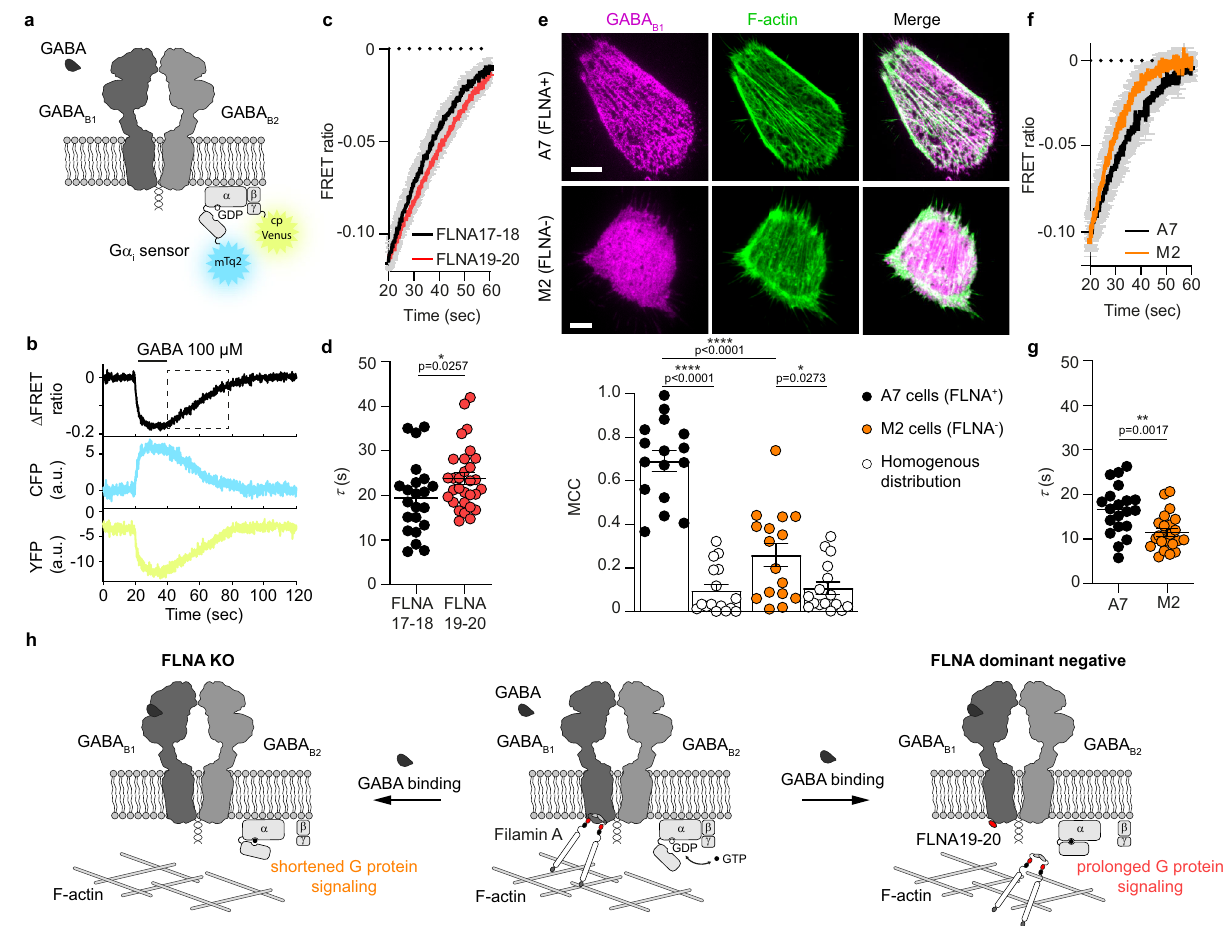
Fig.6|ImpactofGABA B -FLNAinteractionsonG i proteinsignaling.a Schemeof theFRETsensor 34 usedtomonitorG i proteinactivationinreal-time.Thisconsistsof asingleplasmidencodingG α i fusedtothe fl uorescentdonormTurquoise2(mTq2), G β 1 ,andG γ 2 fusedtothe fl uorescentacceptorcp173Venus(cpVenus).Adecreasein FRET is indicative of G i protein activation. b Representative FRET measurement of G i protein activation and deactivation in response to transient GABA stimulation (100 µ M). c ComparisonofthekineticsofG i proteindeactivationfromexperiments asin b inthepresenceofFLNA17-18orFLNA19-20.Dataaremean±SEM. n =22and 30cells(FLNA17-18andFLNA19-20,respectively)examinedoverthreeindependent experiments. d Corresponding estimated time constants ( τ ) for G i protein deacti- vation. Data are mean±SEM. n =22 and 30 cells (FLNA17-18 and FLNA19-20, respectively)examinedoverthreeindependentexperiments. e Top,representative imagesofGABA B1 (magenta)over-expressedinM2cells(FLNA − )orA7cells(FLNA + ) together with Lifeact-GFP (green). Scale bars, 5 µ m. Bottom, corresponding